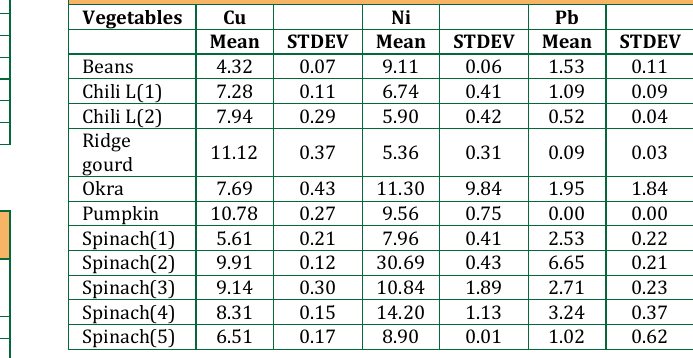
Table 6 (a): Average Concentration of Metals mg -kg in Vegetables in